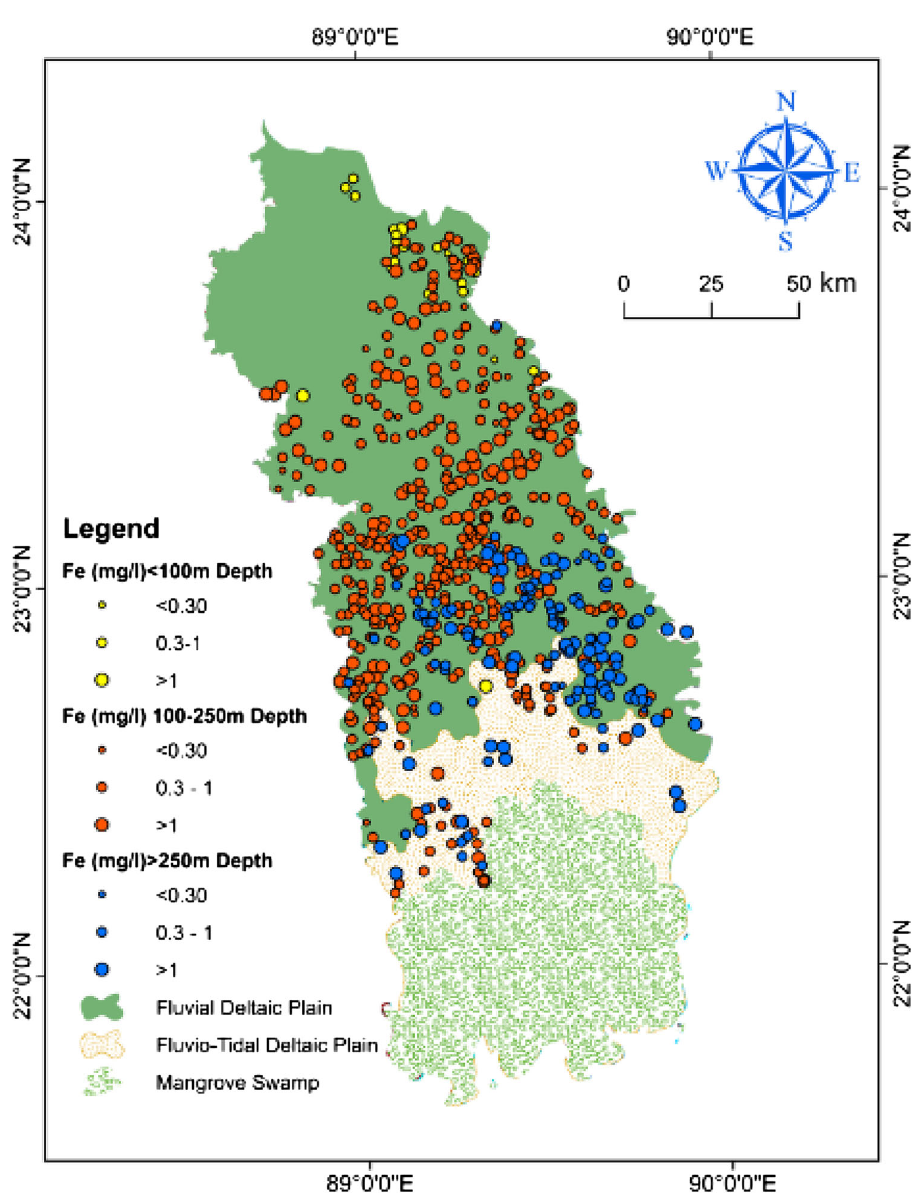
Fig. 12 Spatial distribution map of iron concentrations at various depths in relation to